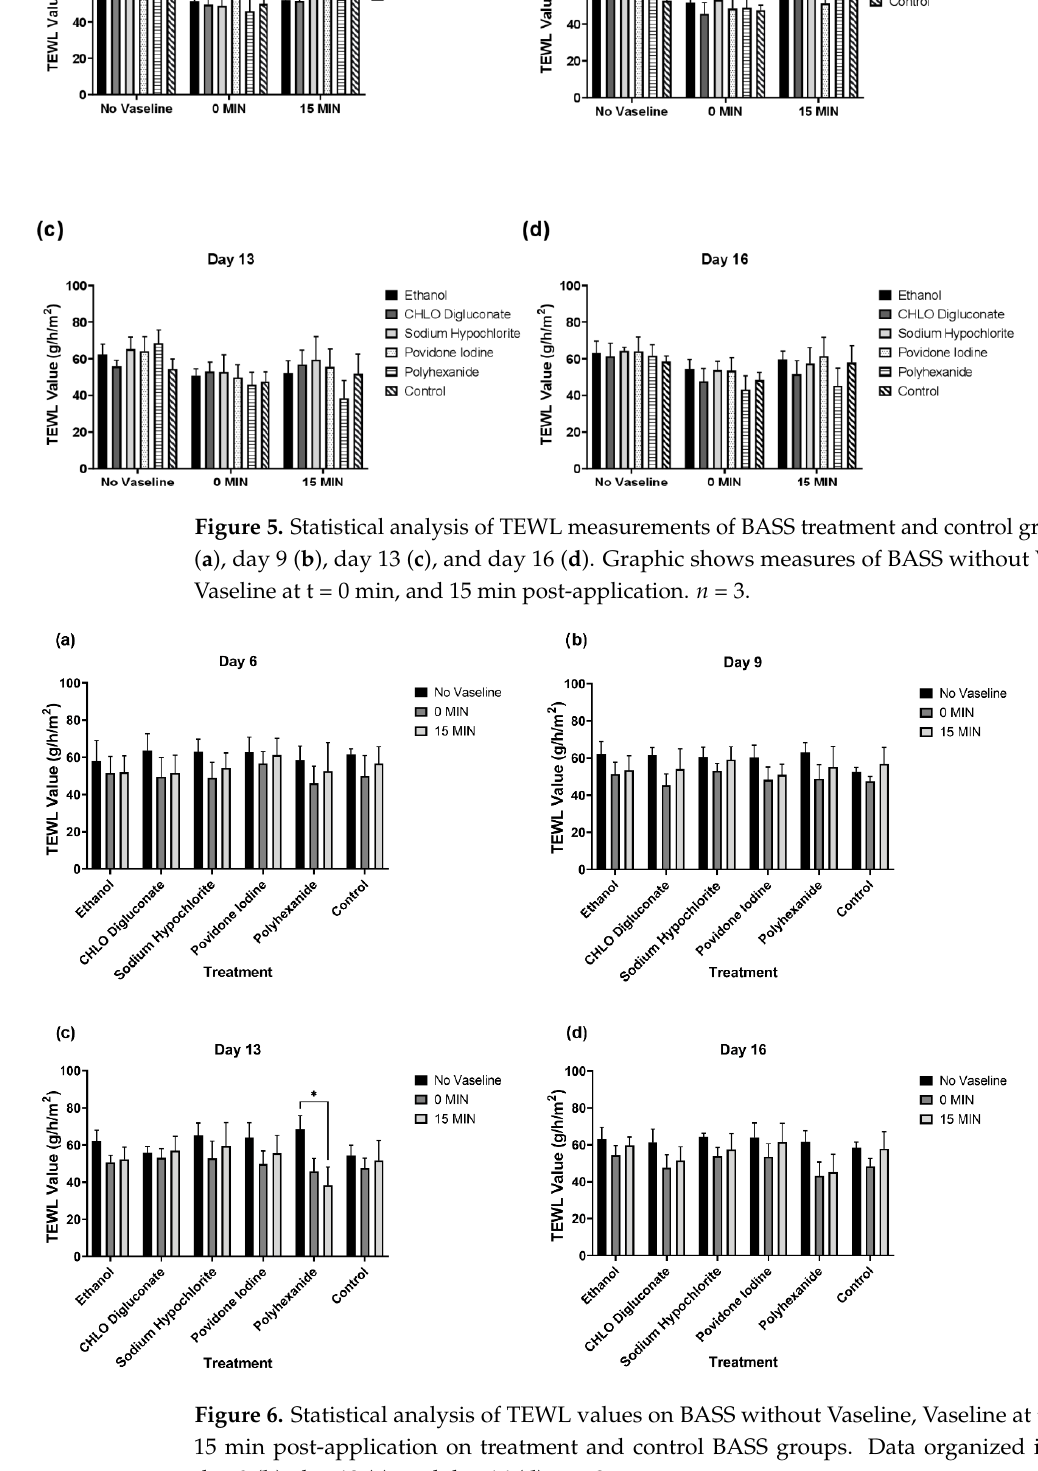
Figure 6. Statistical analysis of TEWL values on BASS without Vaseline, Vaseline at t = 0 min, and 15 min post-application on treatment and control BASS groups. Data organized into day 6 ( a ), day 9 ( b ), day 13 ( c ), and day 16 ( d ). n =